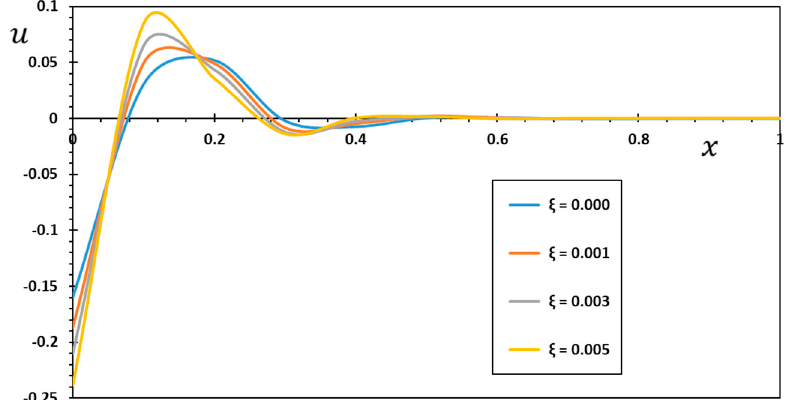
Figure 8. The axial displacement, u , under various nonlocal parameter ξ values.